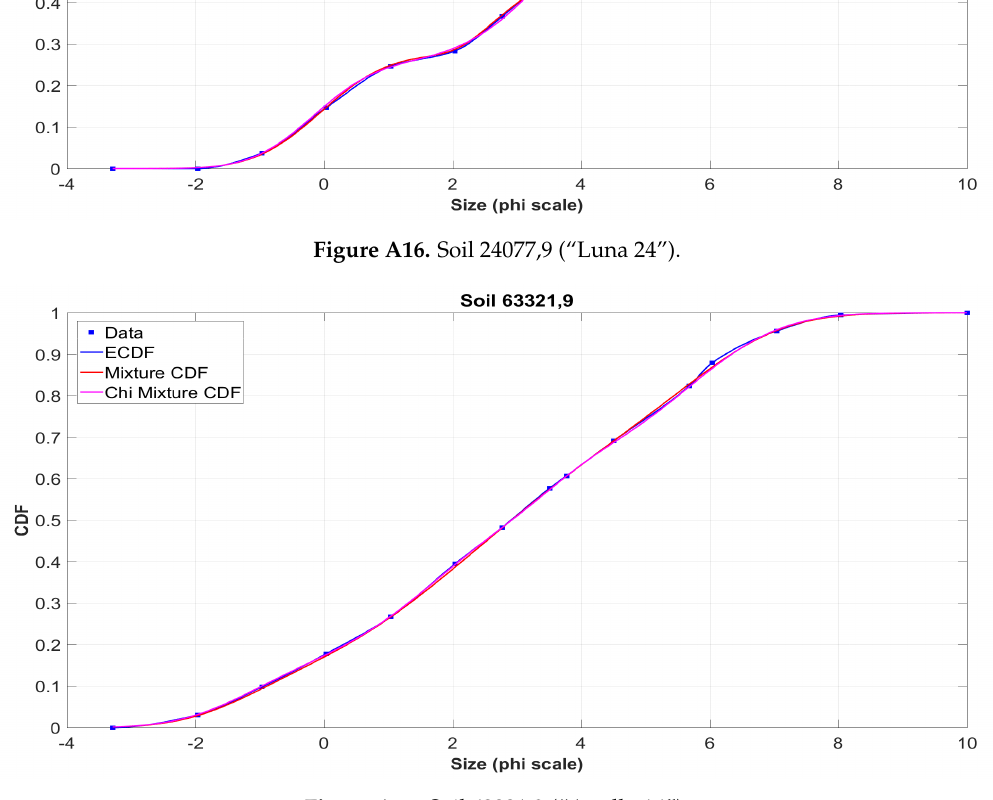
Figure A17. Soil 63321,9 (“Apollo 16”).